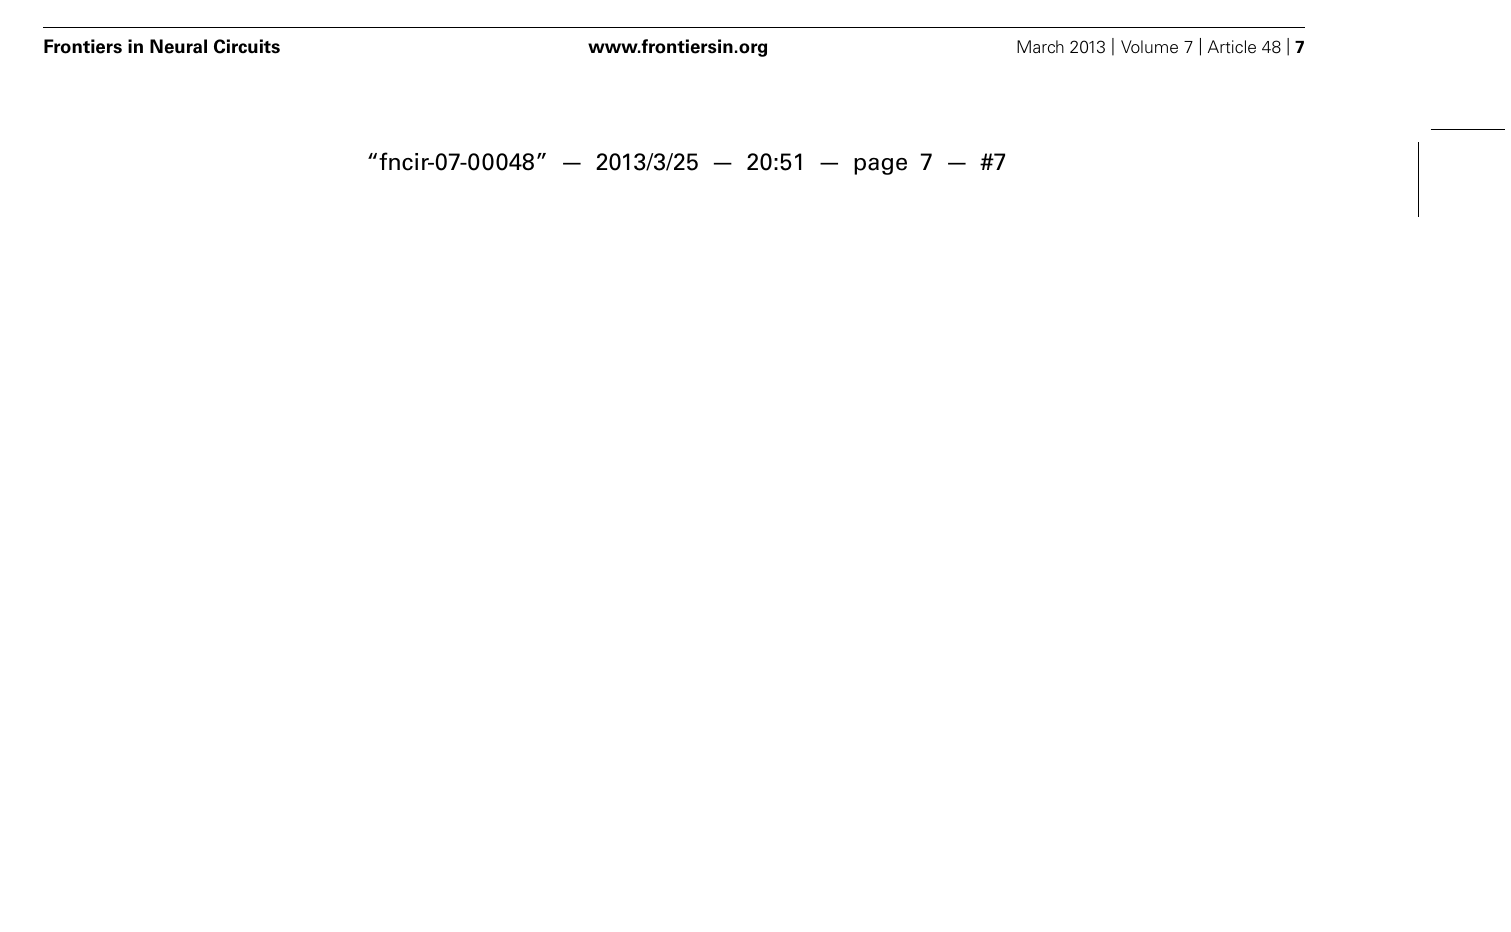
condition.The black fields indicate that more than 95% ( p < 0.05) of the pairs were statistically significant. Note, for PG the P2 component is split in two subcomponents, P2-1 and